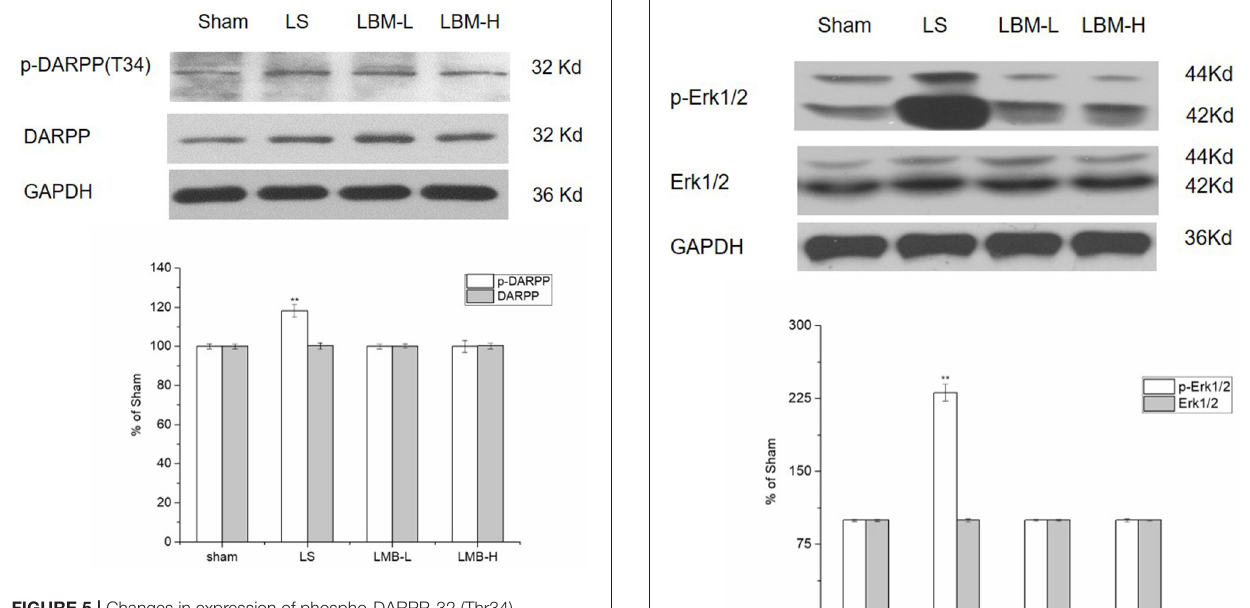
FIGURE 5 | Changes in expression of phospho-DARPP-32 (Thr34), DARPP-32 after either intermittent or continuous L-dopa administration in 6-OHDA-lesioned striatum for 21 days. The phospho-DARPP-32 (Thr34) level in the LS group was much higher than the sham, LBM-L group and LBM-H group ( p < 0.01). No difference was found in the phospho-DARPP-32 (Thr34) level among the LBM-L and LBM-H and sham group ( p > 0.05). The total amount of DARPP-32 remained stable in all groups ( p > 0.05). All above protein levels expressed relative to GAPDH levels. The da0074a are expressed in terms of means ± SD and expressed as a percentage of the sham group. ** p < 0.01 vs. sham group ( n = 5 per group).